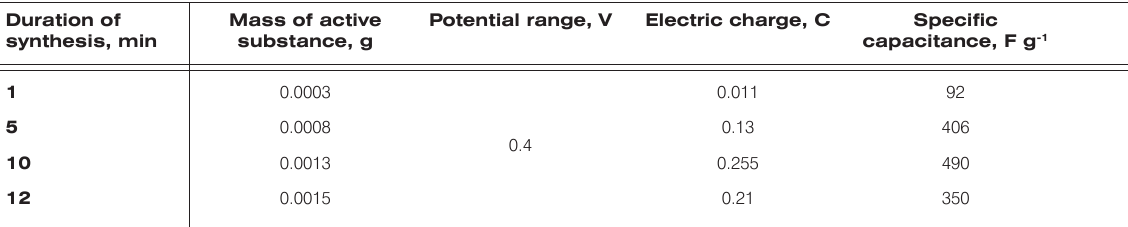
Table 2. Capacitive characteristics of Co